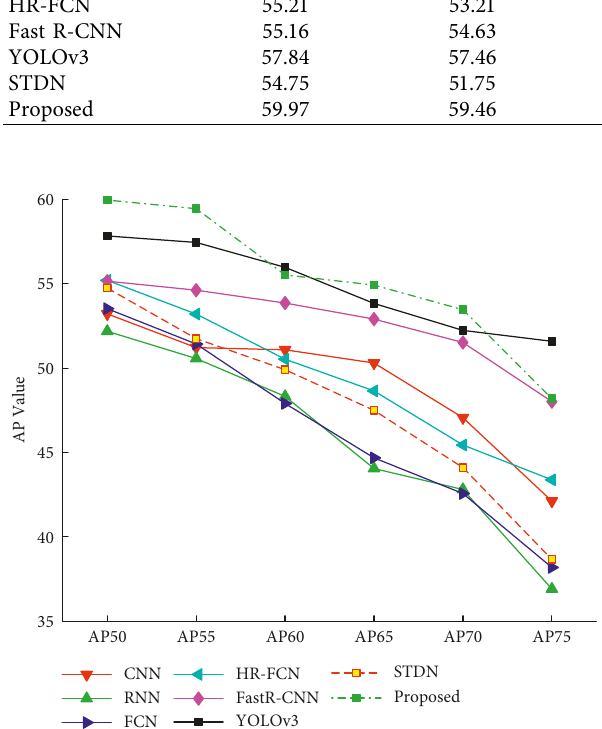
Figure 9: AP obtained by each model under different confidence levels.